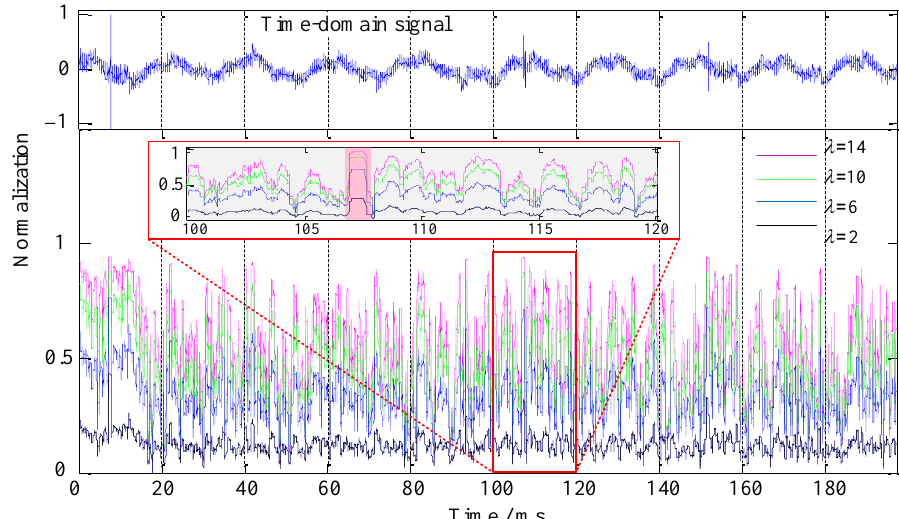
Figure 13. Recognition performance of λ in the aquaculture engineering application experiment, where ξ = 0.2.